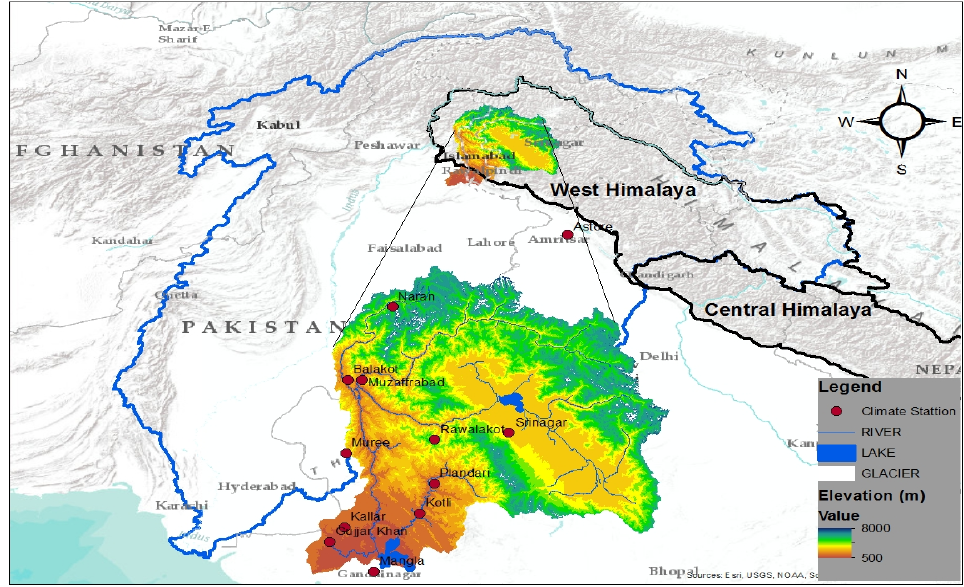
Figure 1. Study Area in Northwest Himalayas.